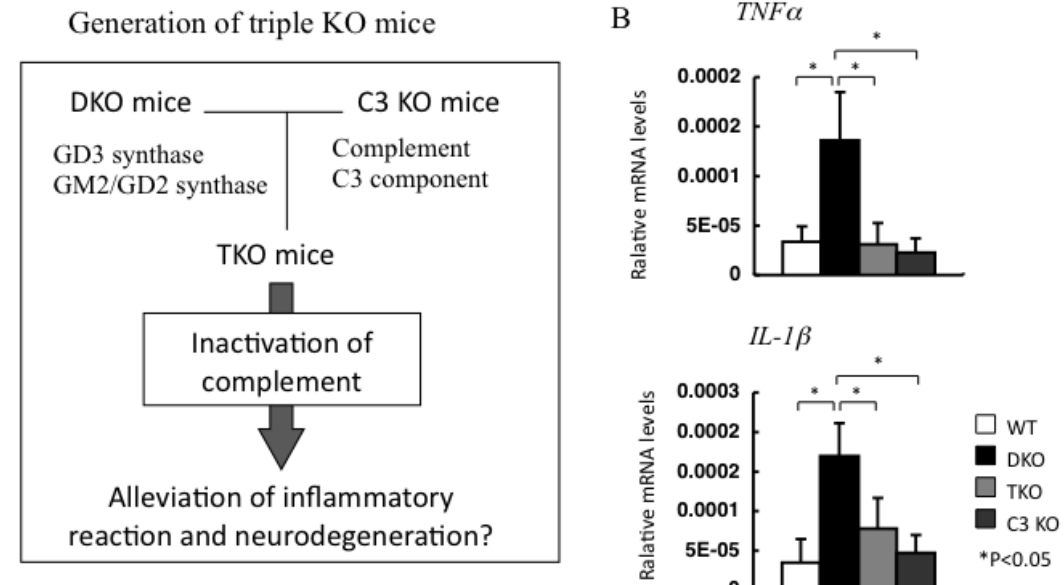
Figure 4. Inflammatory reactions in DKO mice were suppressed by genetic disruption of complement system. ( A ) Triple KO (TKO) mice were generated by mating DKO mice with C3 KO mice to clarify the roles of complement systems in brain disorders in DKO mice. ( B ) Expression levels of inflammatory cytokines were reduced in TKO mice. Relative mRNA levels of TNF α and IL-1 β were compared using RT-qPCR.